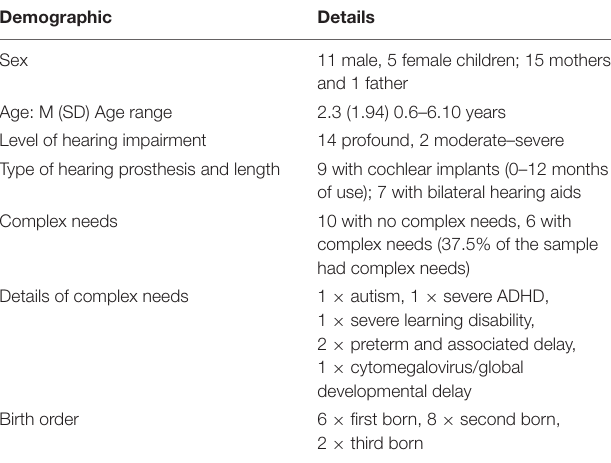
TABLE 1 | Demographic details of the deaf and hard-of-hearing children ( N = 16). Demographic